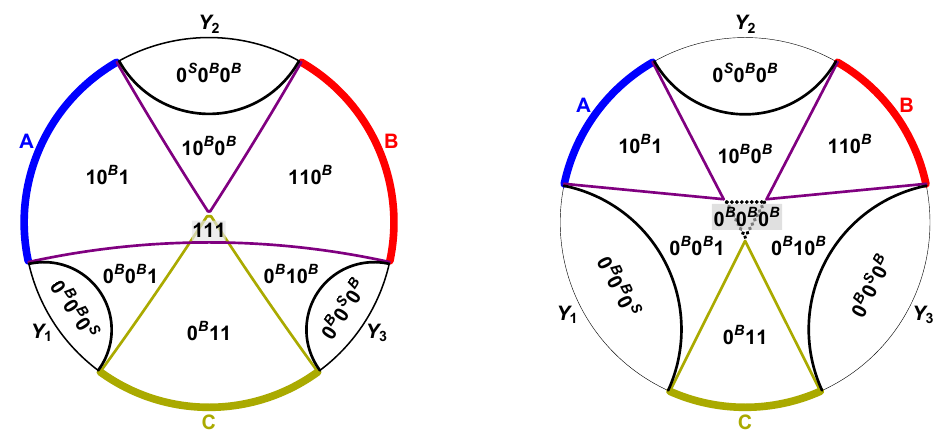
Figure 8 . The regions U r in both auxiliary geometries. The boundaries of U AB are marked in purple, the boundaries of U ABC in black, and the boundaries of U C in yellow. In geometry II, U ABC excludes the little central region 0 B 0 B 0 B , but this does not a(cid:11)ect the coloring of ABC ; we mark this inconsequential boundary of U ABC in dotted black. Collectively, the boundaries of U AB , U ABC , and U C coincide with the boundaries of W AB , W BC , and W AC from (cid:12)gure